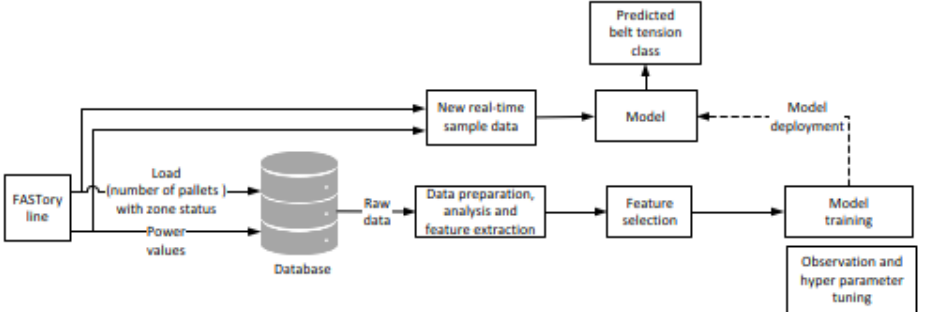
Figure 7. Main steps for development of the data-driven prognostic